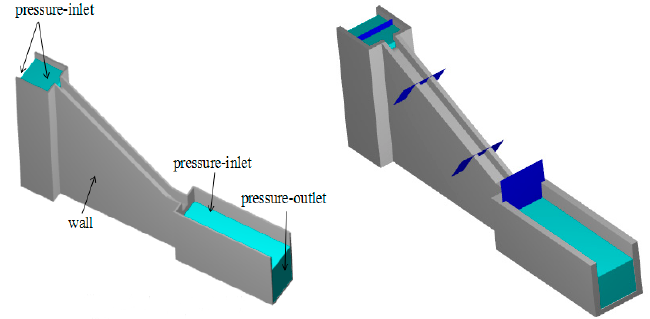
Figure 4. Specified boundary conditions for model computation.